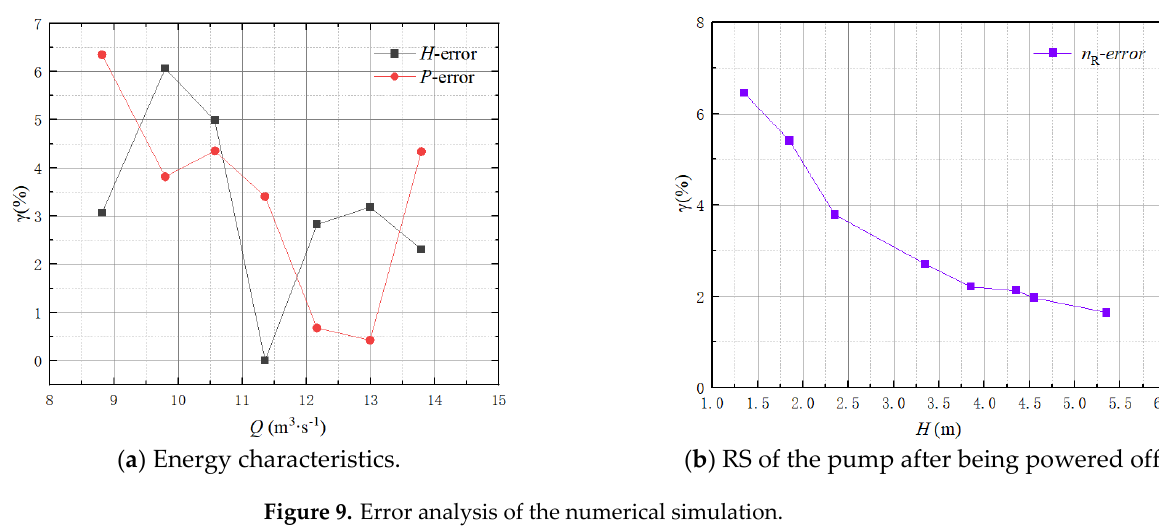
Figure 9. Error analysis of the numerical simulation.